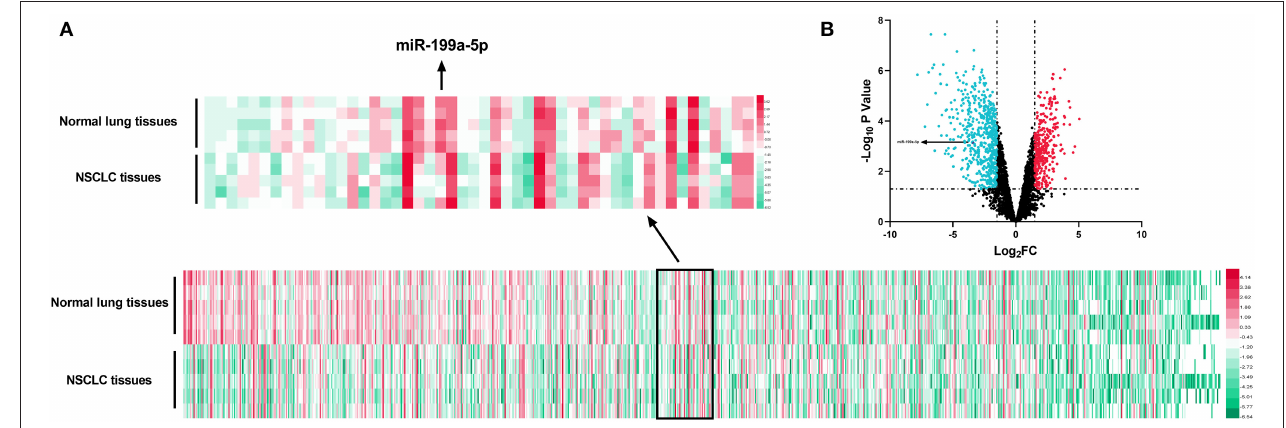
FIGURE 2 | Expression of miRNAs in GSE135981. The heatmap and volcano plot were established with the data in GSE135981. (A) MiRNAs with significant changes of expression level between tumor tissues vs. normal lung tissues and |log 2 FC| > 1.5 were shown in the heatmap. (B) All the miRNAs were shown in the volcano plot, and significantly upregulated miRNAs with log 2 FC > 1.5 were marked in red, while significantly downregulated miRNAs with log 2 FC < − 1.5 were marked in green.